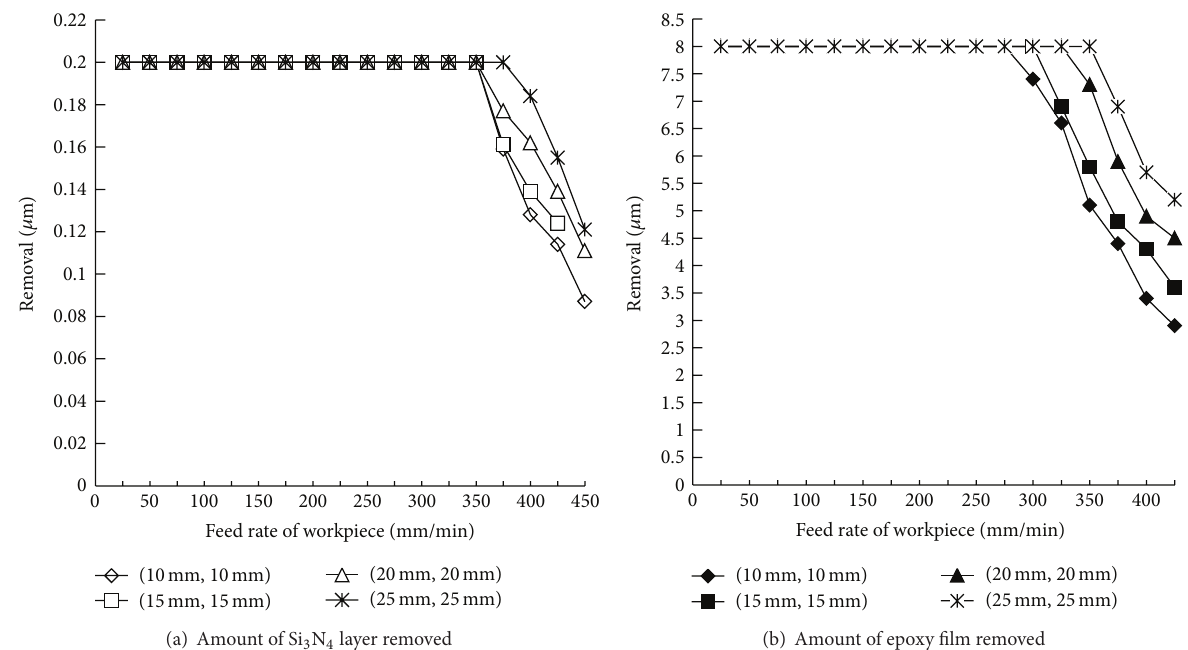
Figure 8: Amount of Si 3 N 4 layer and epoxy film removed at different workpiece feed rates using different combinations of anode radius ( r ) (phosphoric acid 25%wt, NaNO 3 15%wt, PO4-3-P 5%wt, 60 ∘ C, 40 L/min, continuous DC, 150 A, 100kHZ/150W, and cathode radius ( r c 4000 Gauss, shift 800rpm, and tool 900rpm).